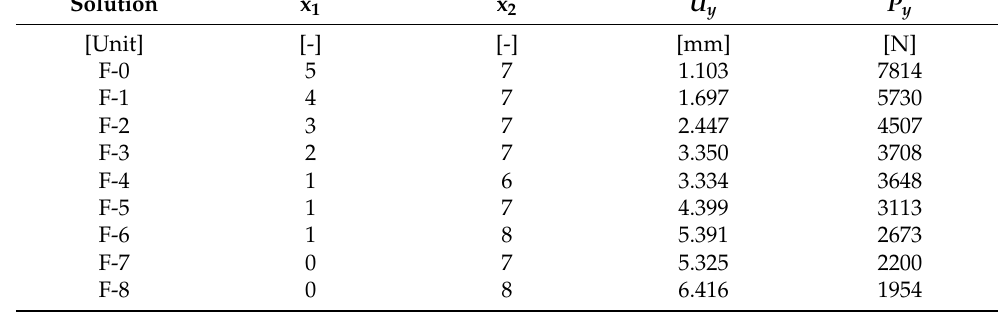
Table 3. Reanalysis results with the 2.5 mm grid elements for the solutions in Table 1.